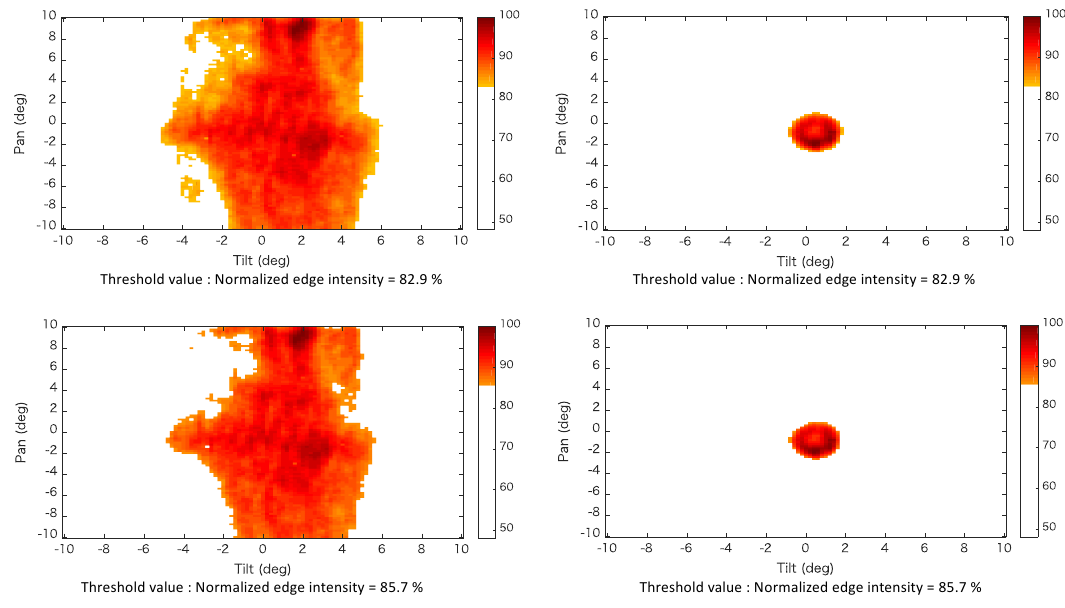
Figure 11. Color map of the observable area that satisfies the threshold values of normalized edge